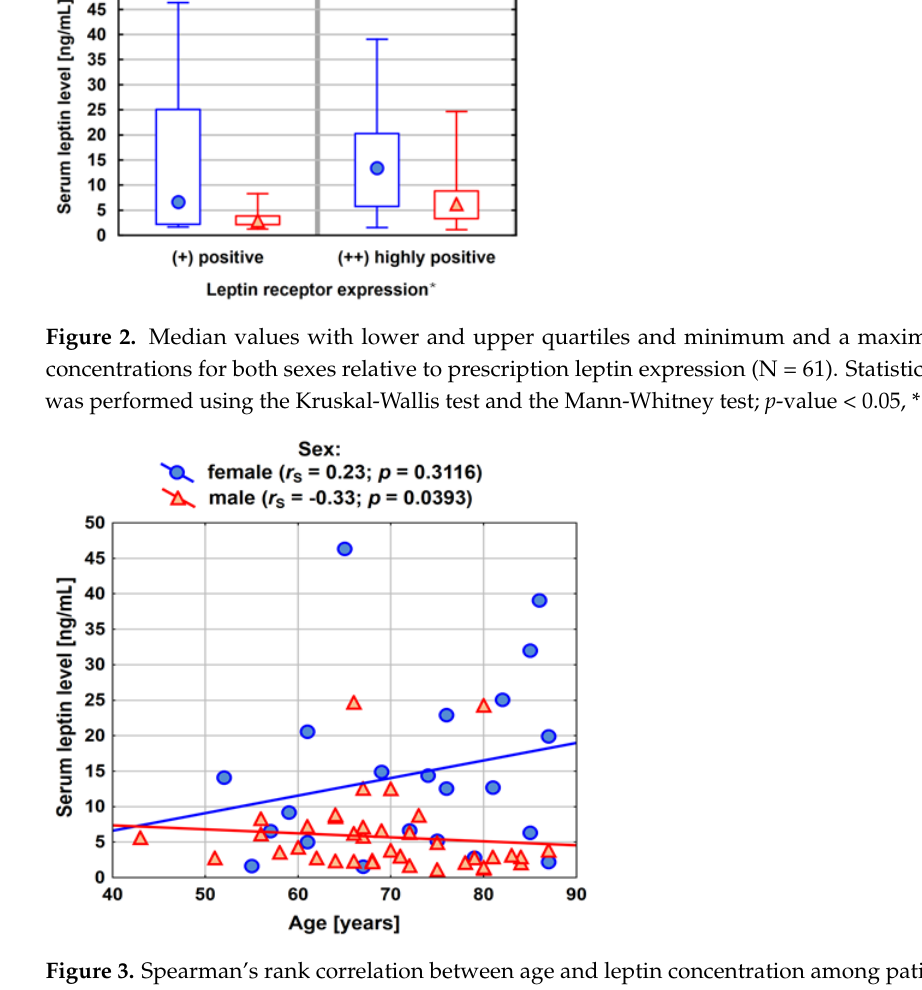
Figure 3. Spearman’s rank correlation between age and leptin concentration among patients in the study group (male: n = 39; female: n = 22).